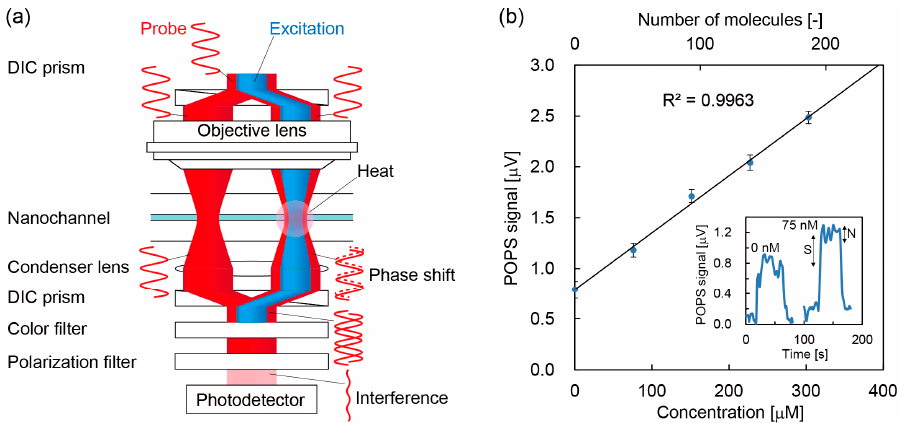
Figure 4. ( a ) Principle of photothermal optical phase shift (POPS). A probe beam (red) is separated by a differential interference contrast (DIC) prism and integrated by another DIC prism. An excitation beam (blue) is not separated and induces a photothermal e ff ect (heat followed by a change in refractive index). The photothermal e ff ect produces a phase shift for one of the probe beams and the phase shift is detected through an interference. ( b ) Detection of non-labeled bovine serum albumin by